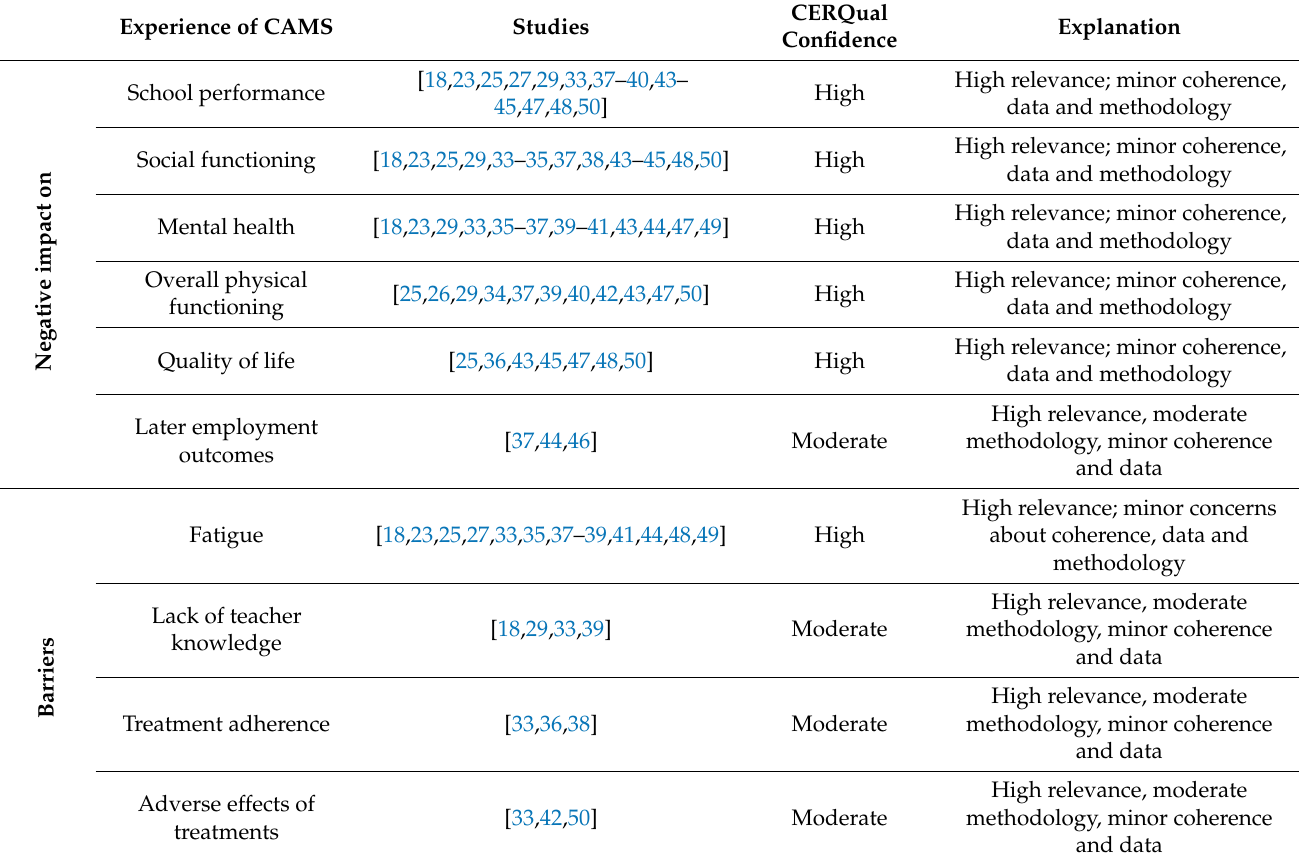
Table 2. Illustrates the Grade-CERQual criteria from the included studies for the experiences of